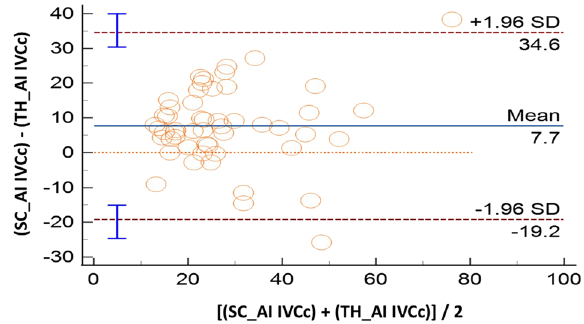
Fig. 4 Bland–Altman plot for the inferior vena cava collapsibility index (IVCc) measured with artificial intelligence (AI) mode in two different sites: subcostal (SC) and transhepatic (TH). SD: standard